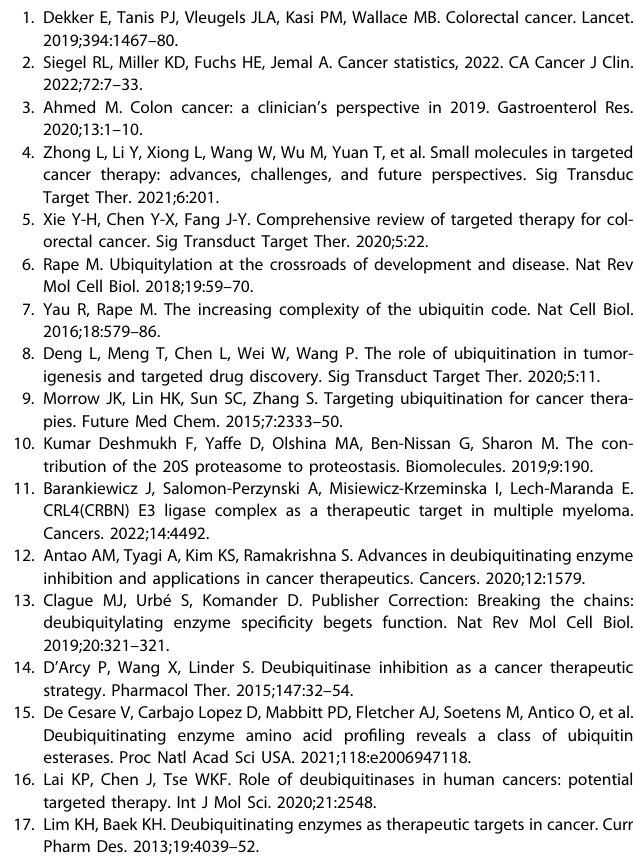
Fig. 6 FUCA1 mediates the impact of USP35 on tumor growth and drug resistance in vivo. B Tumor growth curve of HT29 cells with or without altered expression of USP35 or FUCA1. Cells were subcutaneously injected into the nude mice ( n = 5). A week after the inoculation, water, OXA (10 mg/kg), or OXA (5 mg/kg) plus 5-FU (50 mg/kg), was intraperitoneally injected in the mice weekly. Tumors were measured at the indicated time points. A Representative images of the dissected tumors were shown. A ruler is used to demonstrate the size of the tumors. C Quanti fi cation of tumor weights at the end point. D Cell apoptosis was detected using TUNEL assay of the tumor sections. E Representative immunohistochemistry (IHC) stainings of USP35 and FUCA1 in the human CRC tissues. F Box plot showing the relative FUCA1 levels in USP35- low and USP35-high patients ( n = 30). Median USP35 or FUCA1 expression was de fi ned as the cut-off point. G The correlation of the expression of USP35 and FUCA1 in the human CRC tissues by IHC staining ( n = 30). H The expression levels of USP35 and FUCA1 in the human CRC tissues and adjacent tissues were detected by western blotting ( n = 8). The data are shown as the mean ± SD. * p < 0.05, ** p < 0.01, *** p < 0.001, # p < 0.05, ## p < 0.01, ### p < 0.001 based on the Student ’ s t